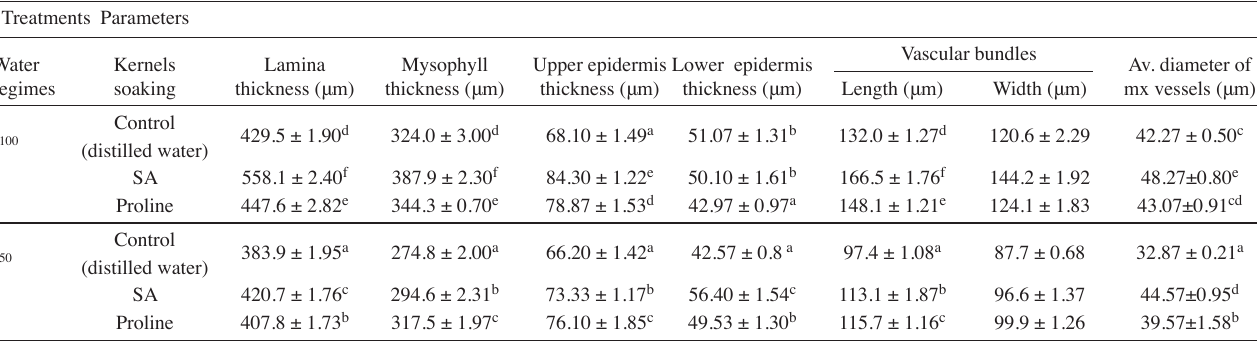
Tab. 8: Effect of kernels soaking in 10 mM proline or 0.1 mM salicylic acid (SA) on leaf anatomical structure of wheat plants ( Triticum aestivum L., cv. Sids -12) grown under normal and field deficit irrigation conditions Treatments